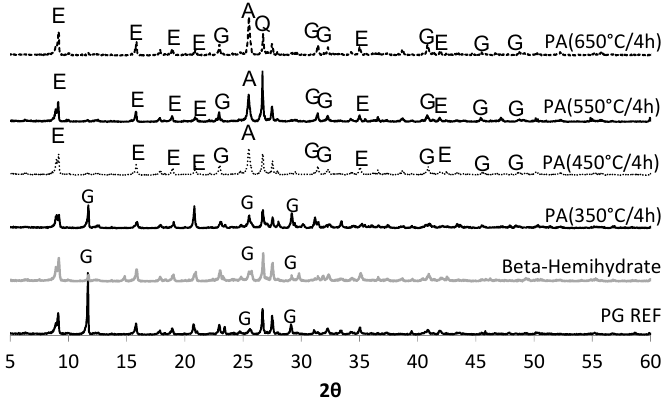
Figure 9. X-ray diffraction patterns for SLUs after 28 days of curing. E = Ettringite, G = Gypsum, A = Anhydrite, and Q = Quartz.